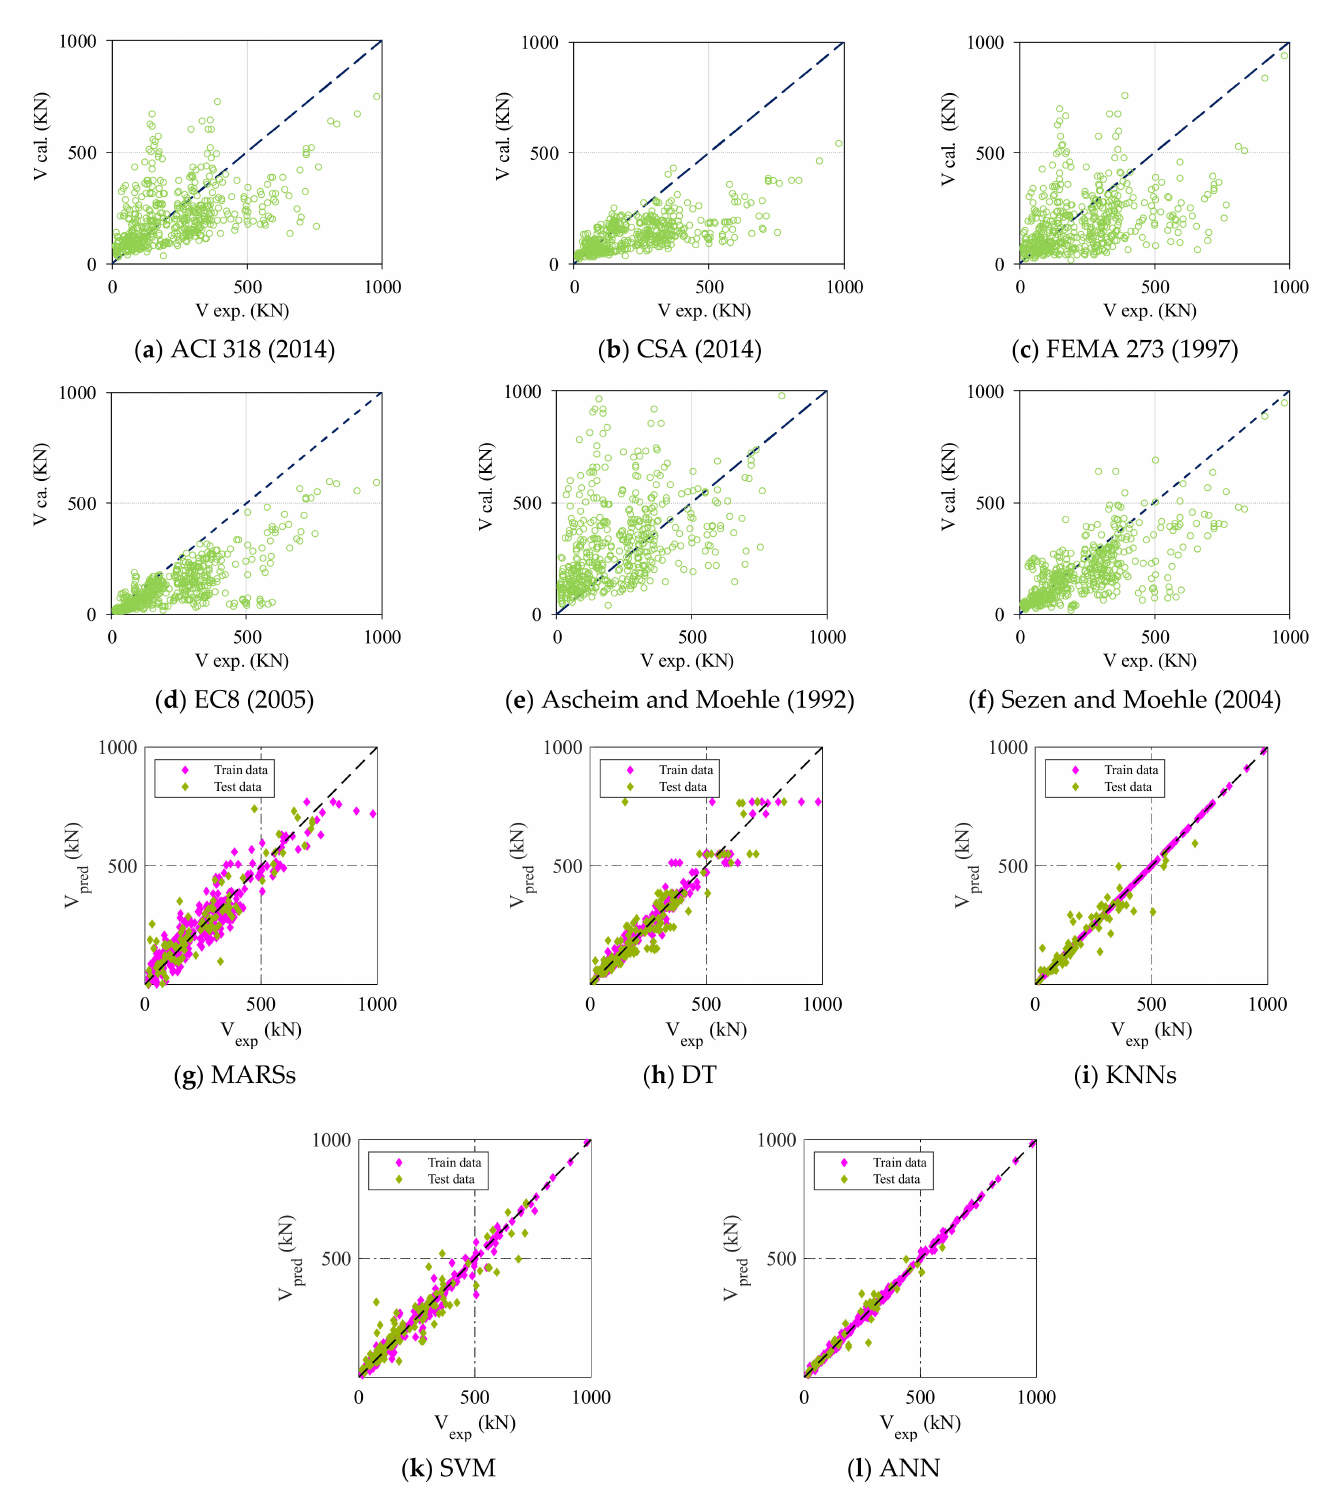
Figure 10. Comparison of shear strengths between experiments and various predicted